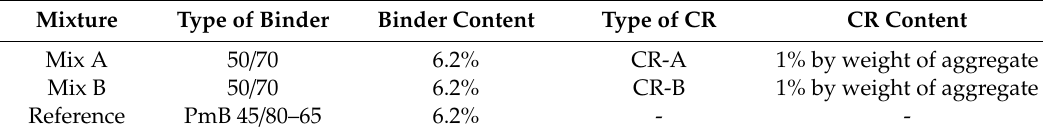
Figure 2. Particle size distribution of the Semi-Dense Asphalt (SDA) mixtures. Table 1. SDA mixtures composition.